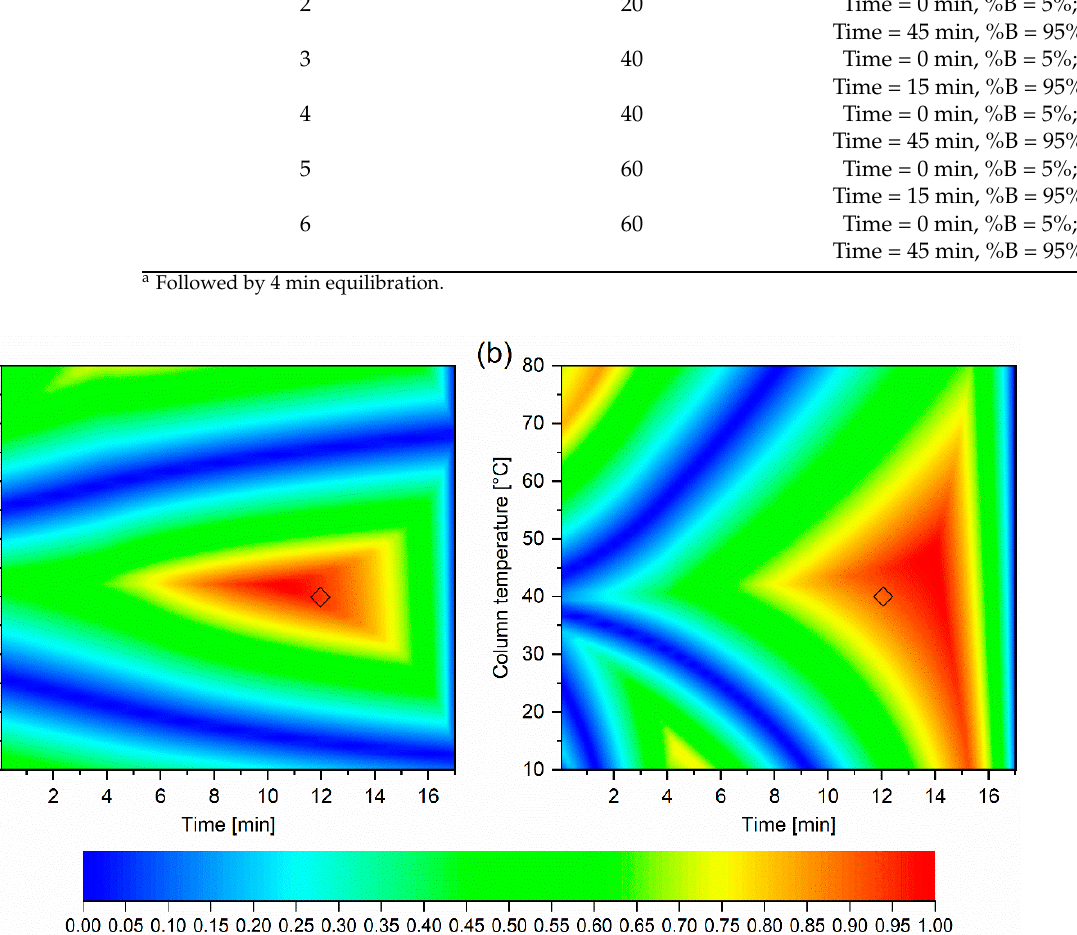
Figure 4. Resolution heat map for key predictive sample set (KPSS). Intensity represents overall chromatogram resolution. High resolution is depicted by red color, low resolution is depicted by blue color. ( a ) constructed from experimental retention times. ( b ) constructed from Quantitative Structure Retention Relationship (QSRR) predicted retention times. The diamond indicates the center point selected from the model created from experi- mental retention times.